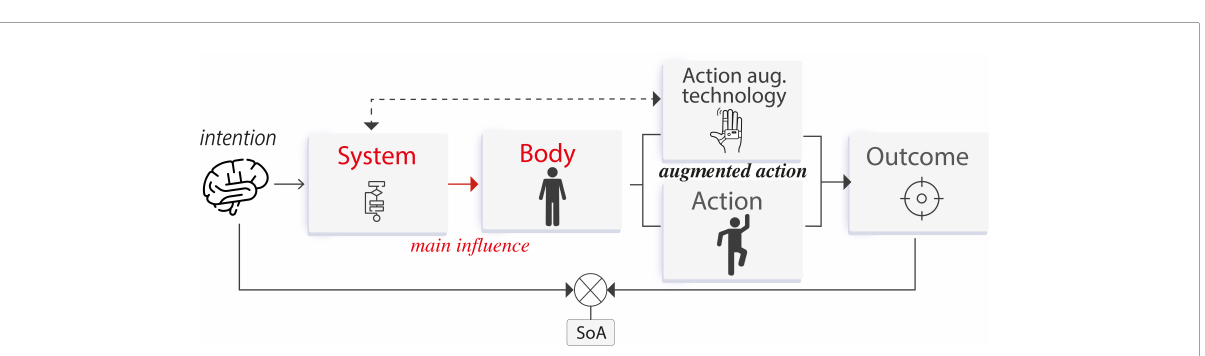
FIGURE8 Agency process for action augmentation technology. The system assists the user’s action to produce the intended outcome. Here also the system often goes beyond bodily